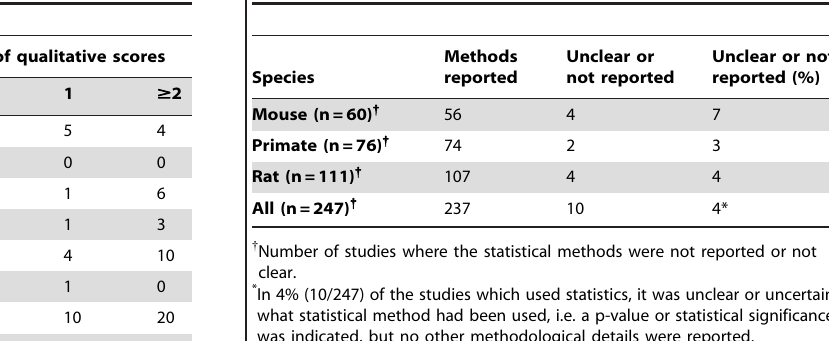
Table 14. Number of studies that used qualitative scores reporting blinding.